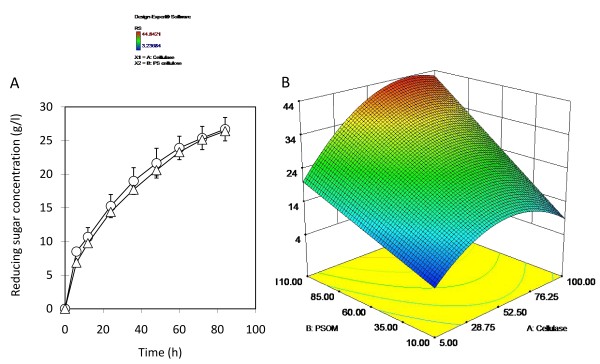
Comparison of hydrolysis between cellulase from paper sludge (PS) and commercial Acremozyme cellulase. (A) Reducing sugars (RS) concentration in PS hydrolysate when using cellulase of PS origin (open circles) and commercial cellulase (open triangles). (B) Surface response of the released RS concentration in an enzymatic hydrolysis of PS using cellulase of PS origin. Error bars in (A) denote 5% error of three repeated experiments.